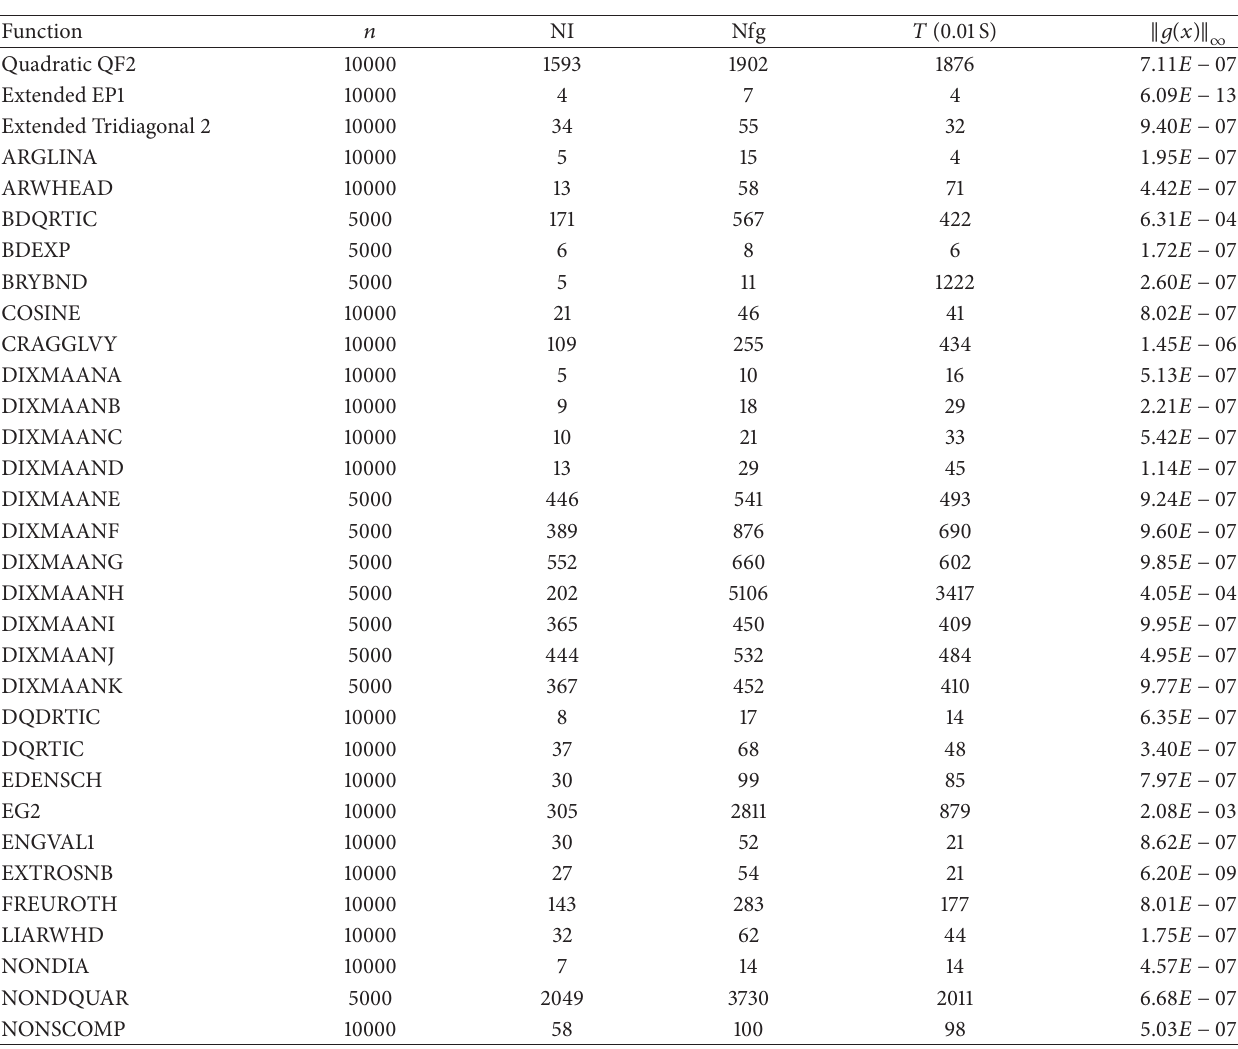
Table 2: Numerical results for HSDY